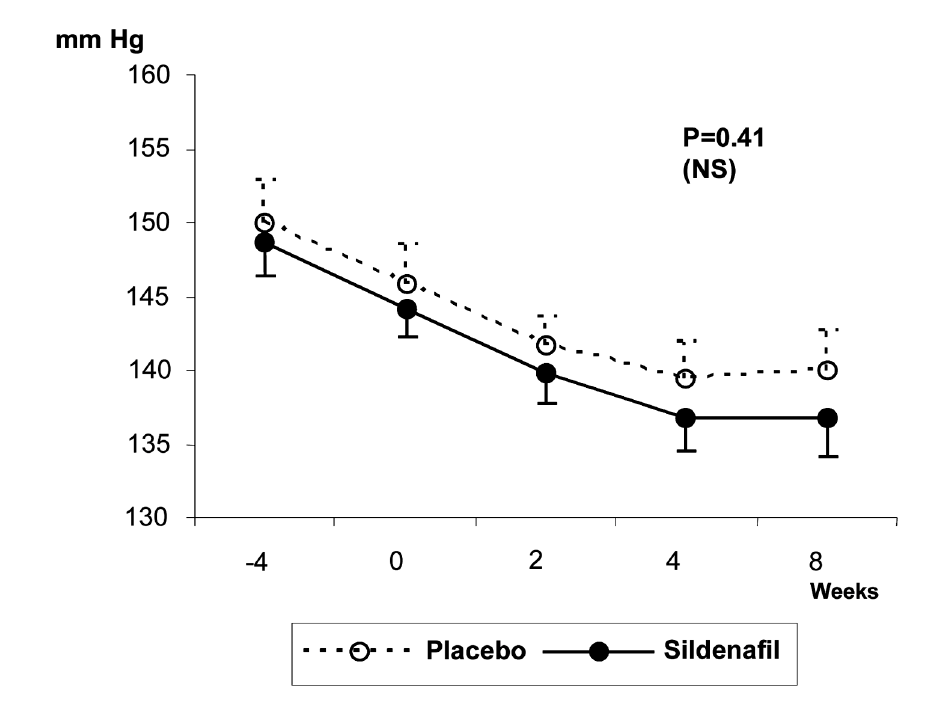
Figure 3 – Blood pressure (BP) behavior during the study. Systolic BP in the supine position. P values refer to the comparisons between sildenafil and placebo. NS = not